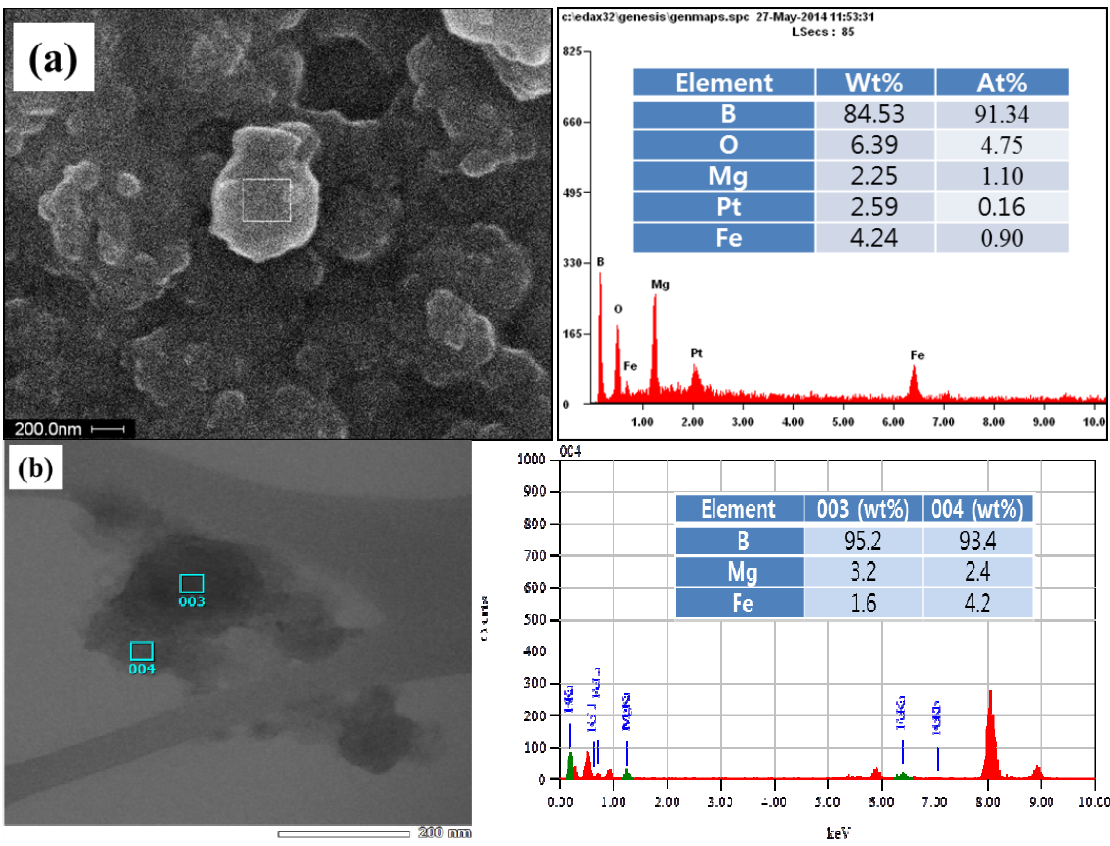
Figure 3. Elemental constitution of B/Fe precursor nanoparticles using: ( a ) SEM; and ( b ) transmission electron microscope (TEM) images coupled with the energy dispersive X-ray (EDX)